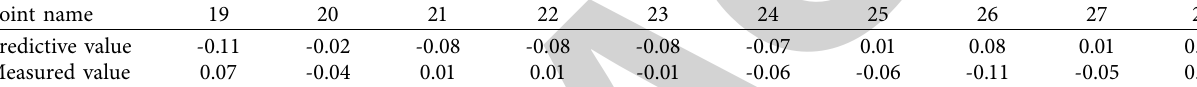
Figure 5: Tilt value comparison graph. Table 3: East measured and predicted curvature value (mmm − 2